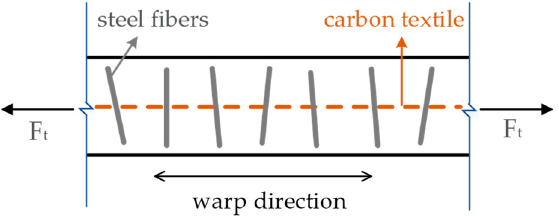
Figure 17. Side view of steel fiber distribution in the CTRM (carbon textile reinforced mortar).